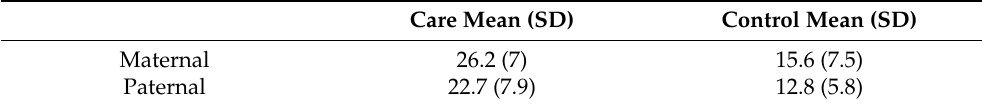
Table 2. Parental Bonding Instrument mean scores (standard deviations) in the First Experimental Study of Transference Interference-In Teenagers (FEST-IT).